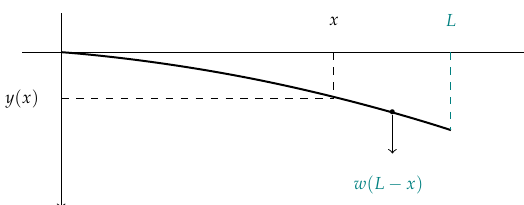
Figure 5. Cantilever beam—uniformly distributed